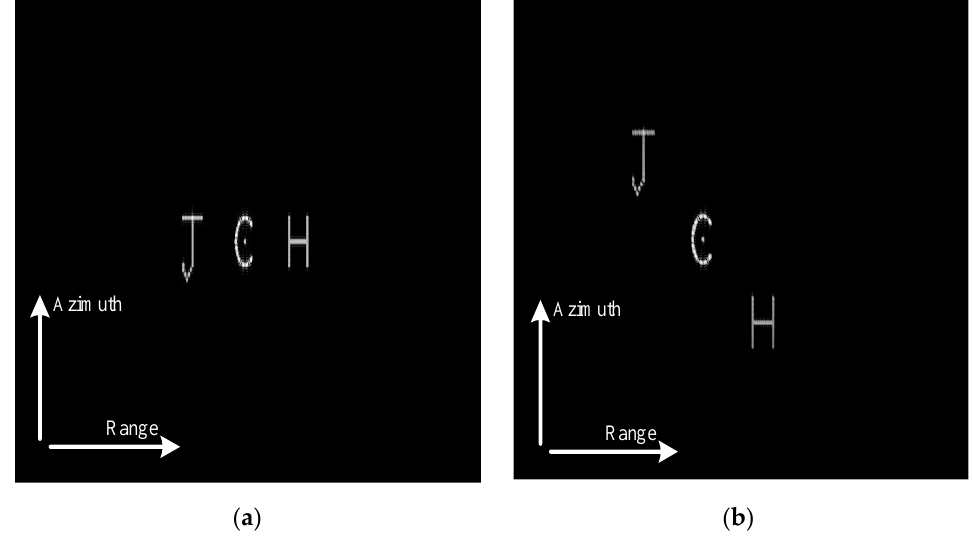
Figure 9. Imaging results of two different sub-apertures. ( a ) Result of the slave image; ( b ) result of the master image.